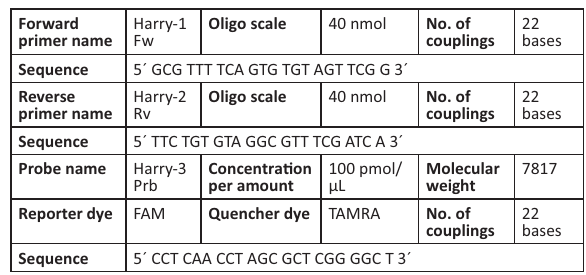
FIGURE 1: Specifications of human herpes virus type 6 primers and probe in Khartoum, Sudan, December 2009 – August